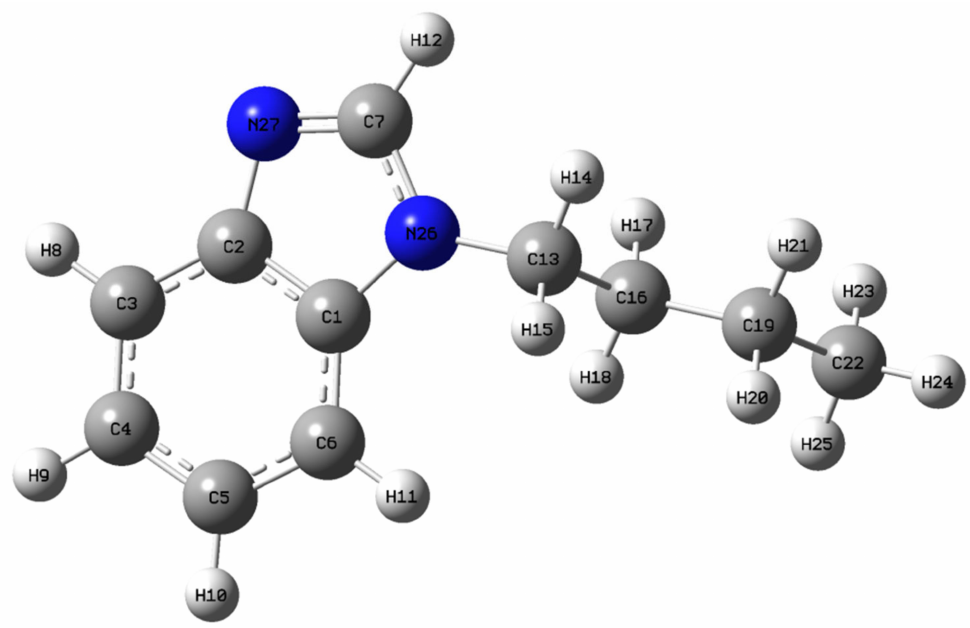
Figure 1. Optimized molecular structure of